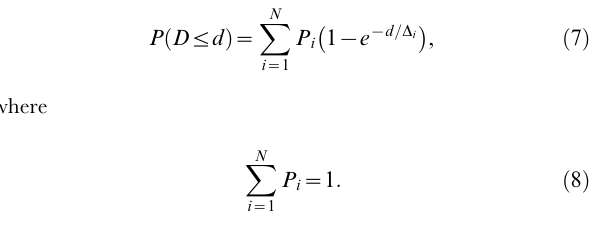
Statistical Point Estimate k off s